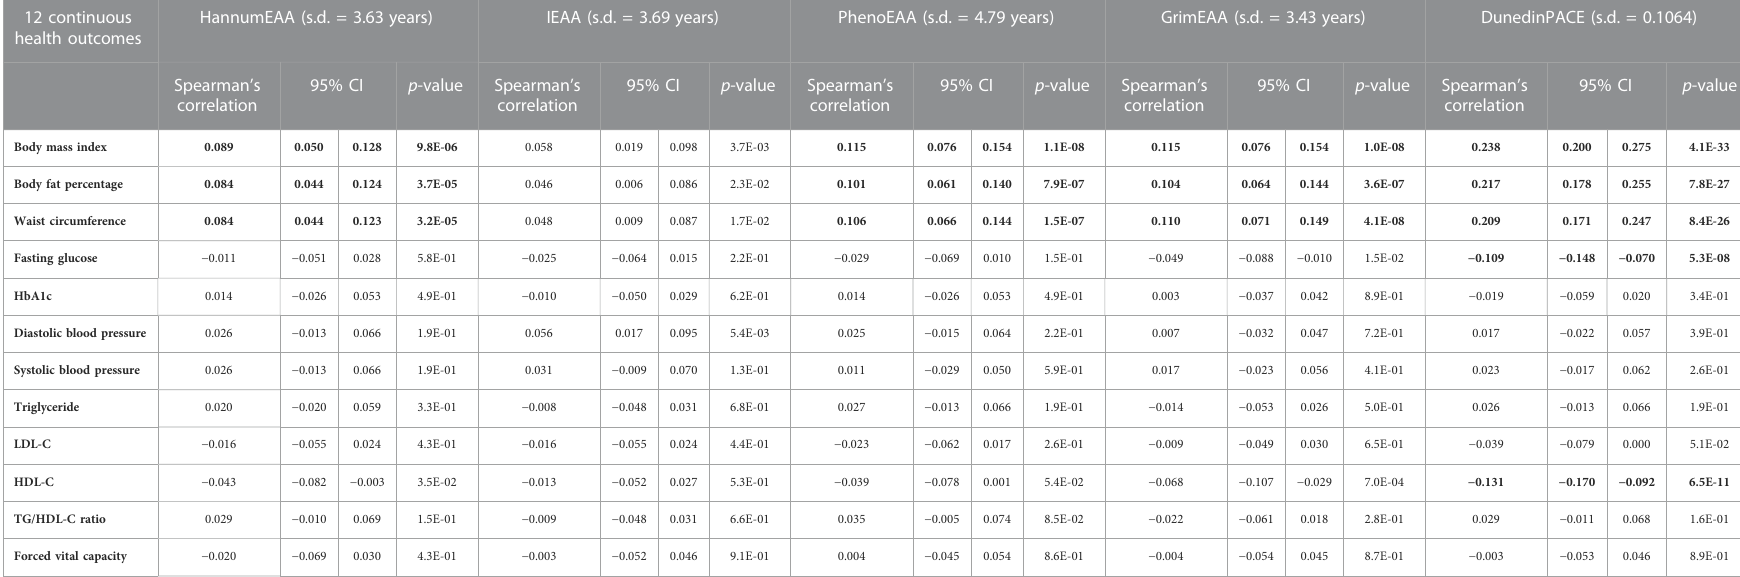
TABLE 2Spearman ’ s rank correlation coef fi cients (with 95% C.I. and p -values) between epigenetic ageacceleration andcontinuous health outcomes. Signi fi cant results with p < 0.05/(25 ×5) =4.0E-4 were highlighted in bold font. 12 continuous health